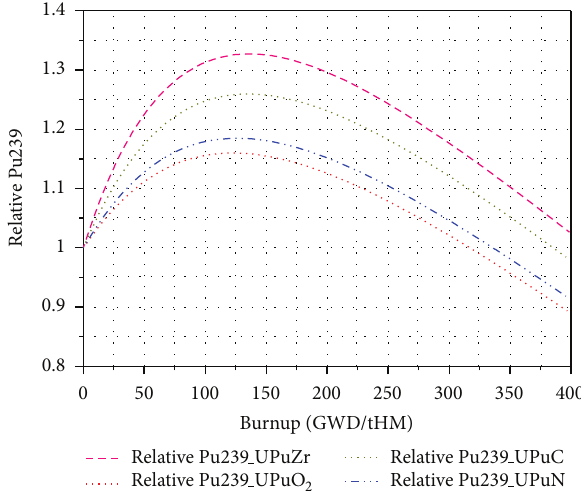
Figure 2: Normalized 239 Pu versus burnup for typical fuel